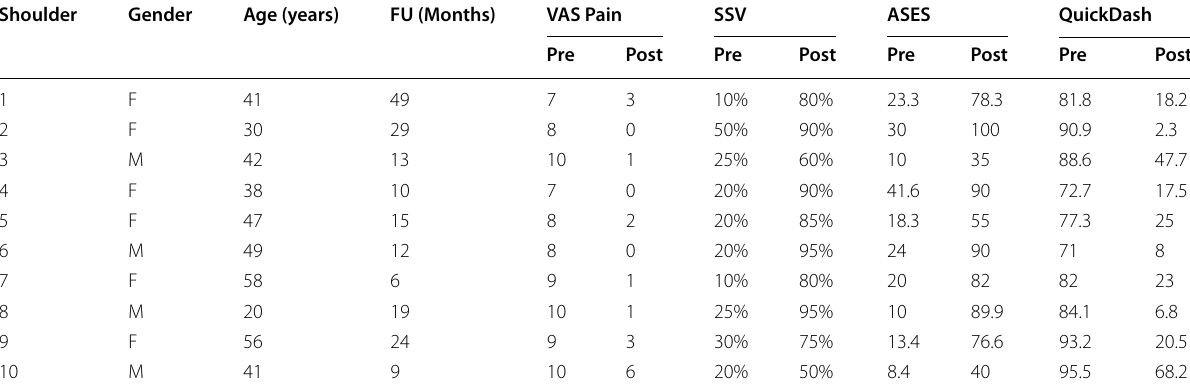
M Male, F Female, VAS Visual analogue scale, SSV Subjective shoulder value, ASES American Shoulder and Elbow Surgeons Score, Pre Preoperative, Post Postoperative